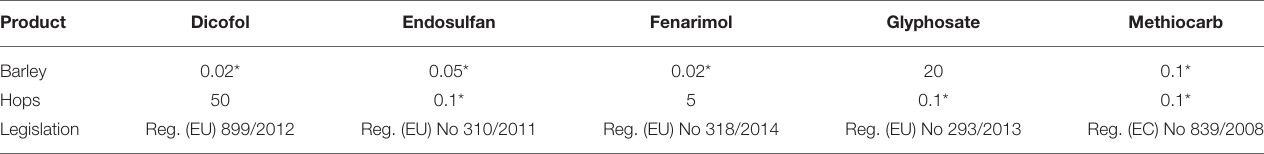
TABLE 1 | MRLs for selected pesticides in hops and barley.